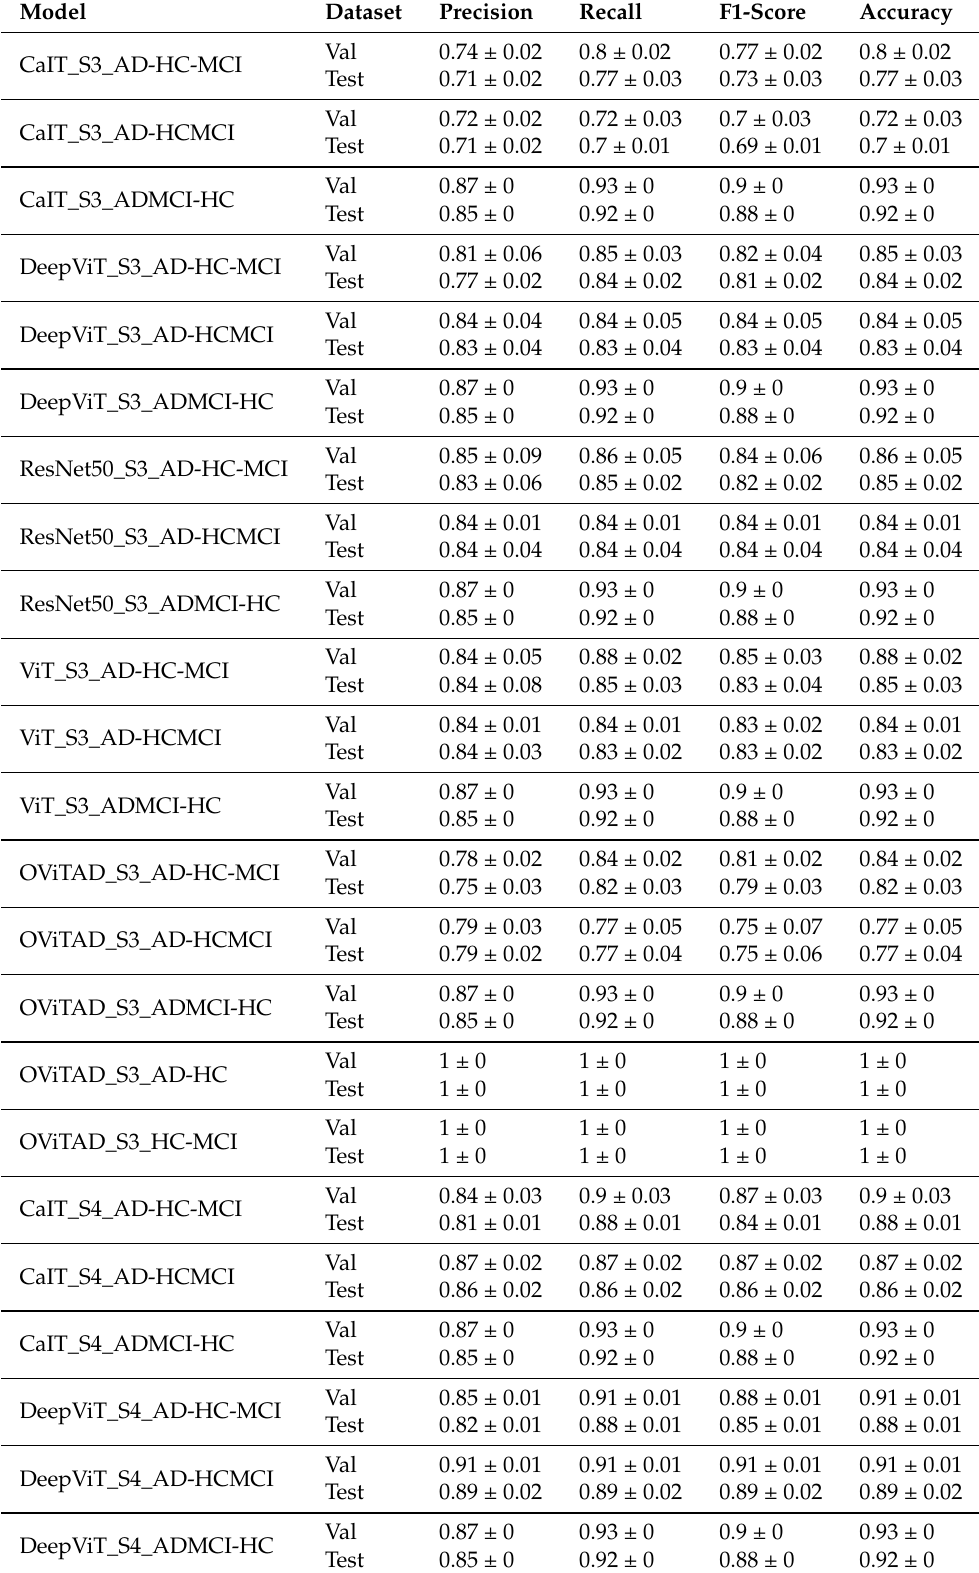
Table 3. The models’ performance of two sets for structural MRI experiments evaluated by standard evaluation